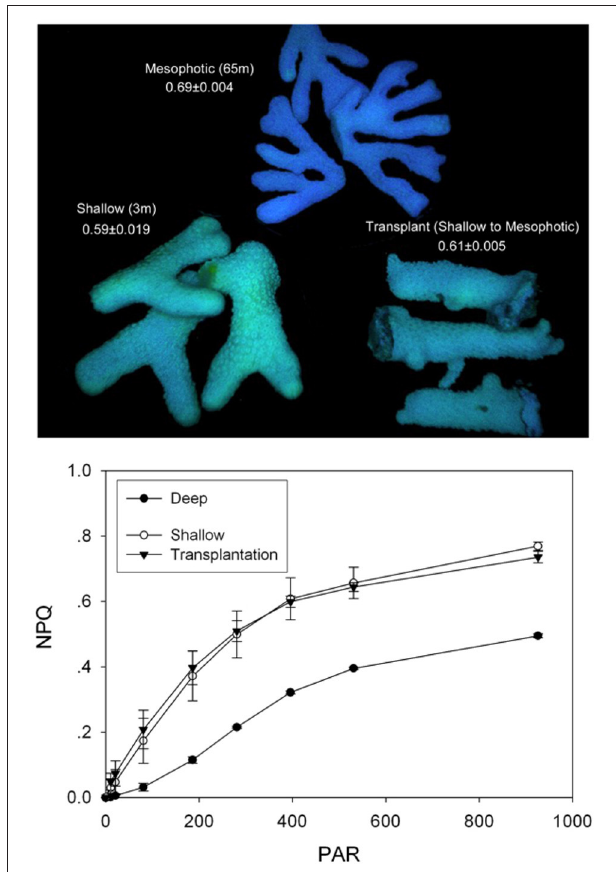
FIGURE 3 | NPQ analysis of mesophotic, shallow and transplanted corals. Measurements were performed using PAM imaging system. The top panel presents a false color image of the coral fragments. The values indicated are Fv/Fm average calculated from three independent fragments. The bottom panel presents NPQ values as a function of incident light intensity for the three coral fragment groups. Mesophotic corals symbionts lose a small fraction of excessive absorbed energy to photoprotective